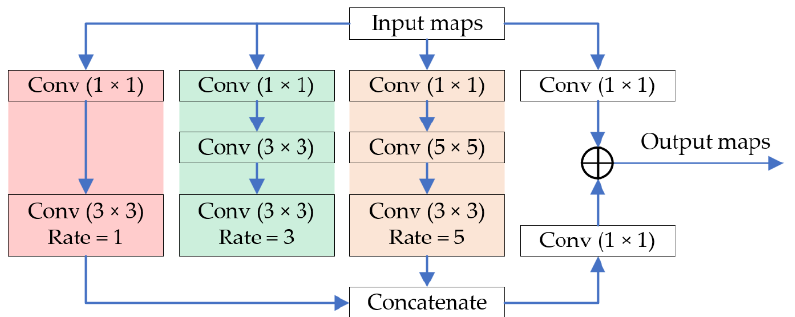
Figure 5. The Receptive Field Blocks (RFB) module. The inputs are the feature maps obtained by the MKM feature extractor or the RM feature extractor. The output is the result of an element-wise addition between the input maps followed by a 1 × 1 convolution and the concatenation from three branches. Note that the channel number of our RFB module is 32.